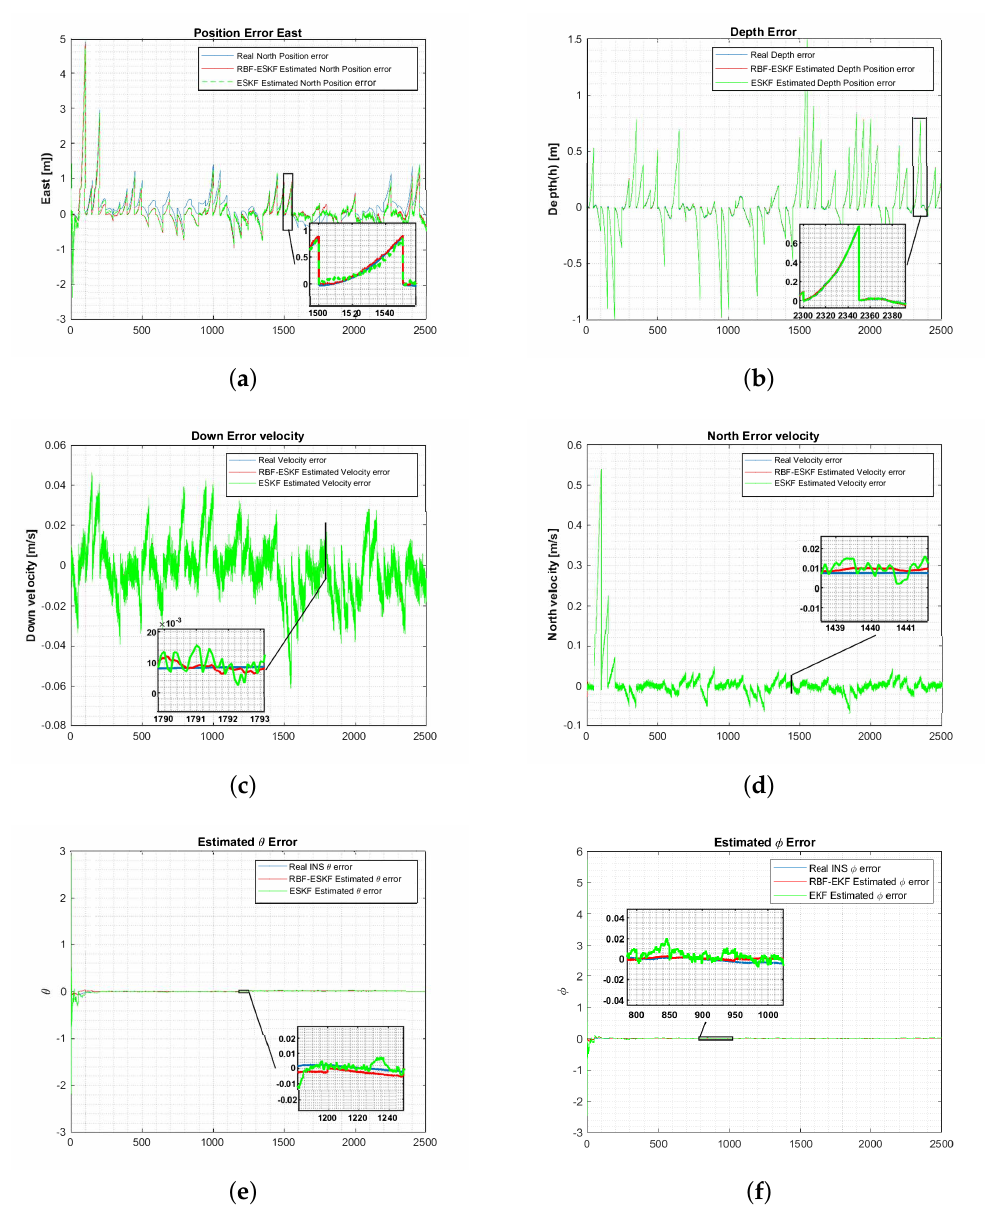
Figure 5. Simulation results of ESKF and RBF-ESKF for time 0–2500 s (x-axis) in case 1. ( a , b ) The RBF-ESKF estimation for the east positions and depth error is close to the actual error value. ( c , d ) Error velocity for down and north. ( e , f ) Euler angle errors for roll and pitch. It is evident from ( c – f ) that ESKF has an oscillatory response that contributes to compromised accuracy compared to